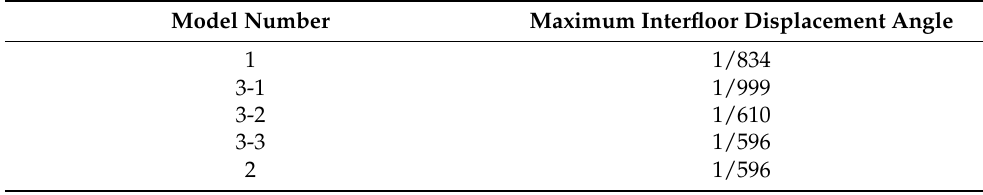
Table 4. Maximum interfloor displacement angle of each